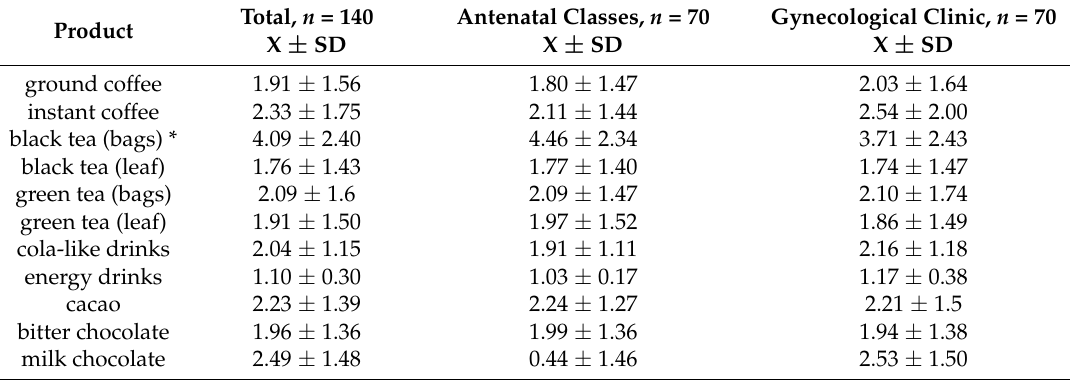
Table 4. Frequency of consumption of selected caffeinated products, in total and by group.